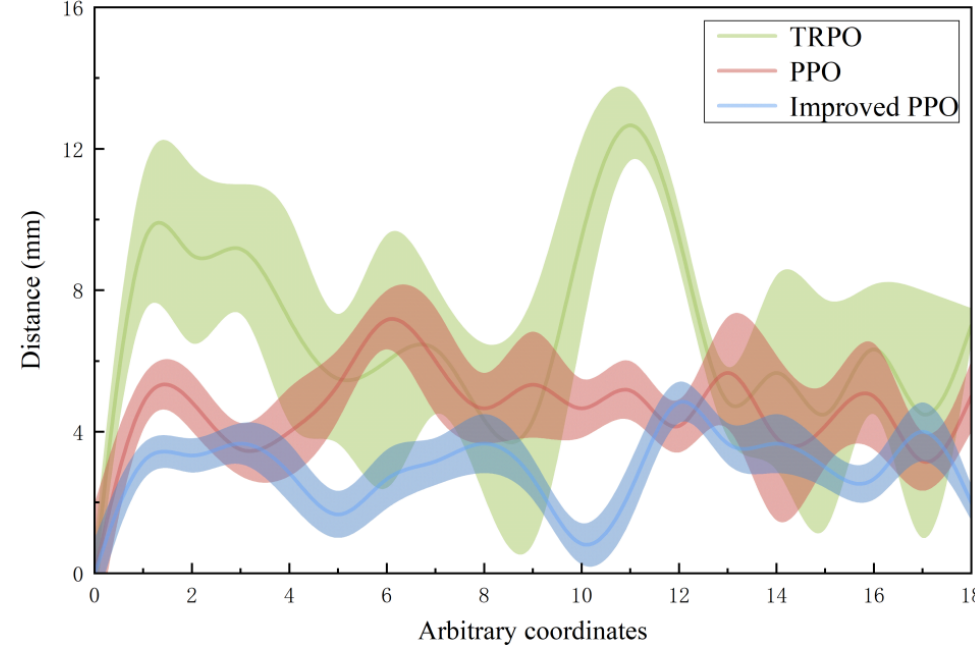
Figure 17. The relationship between the end of the robotic arm and the distance of the random target under three algorithms.